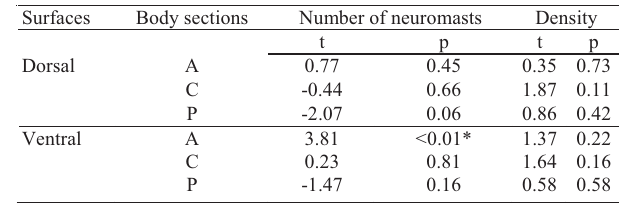
Table 4. Comparisons of the numbers of neuromasts among the different body sections (A = anterior, C = central, and P = posterior) on both the dorsal and ventral surfaces of Potamotrygon motoro and P . orbignyi . Significant results marked with an asterisk (*=higher in A; **=higher in P).